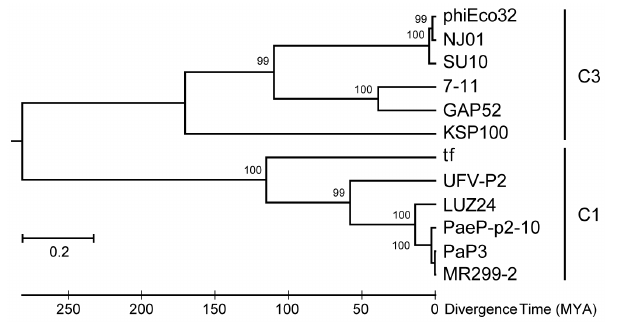
Fig. 5. Phylogenetic tree showing the relationship of the two structural proteins, the scaffold protein and the head protein, within and between the two morphotypes. Phages SU10, NJ01, PhiEco32, GAP52, 7–11, and KSP100 belong to the C3 morphotypes (elongated capsid), and phages tf, UVF-P2, LUZ24, PaeP- p2-10, MR299-2, and PaP3 to the C1 morphotype (icosahedral capsid). The tree was inferred by using the Maximum Likelihood method based on the Whelan and Goldman model [23]. The tree with the highest log likelihood ( 2 9785.9307) is shown. A maximum parsimony (MP) tree was used as an initial tree in the heuristic search. The tree is drawn to scale, with branch lengths measured in the number of substitutions per site. The analyses were conducted in MEGA6